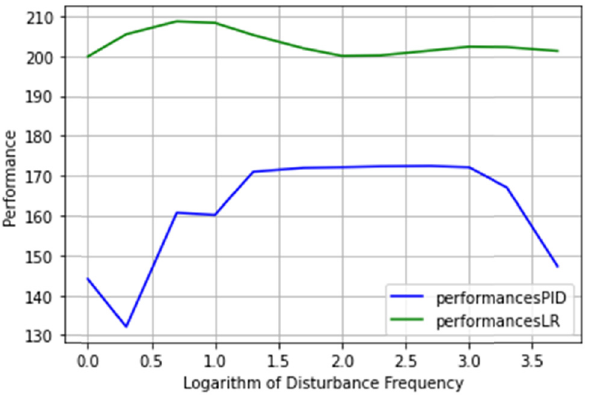
Figure 14: Performances of PID and LR controllers for various dis - turbance